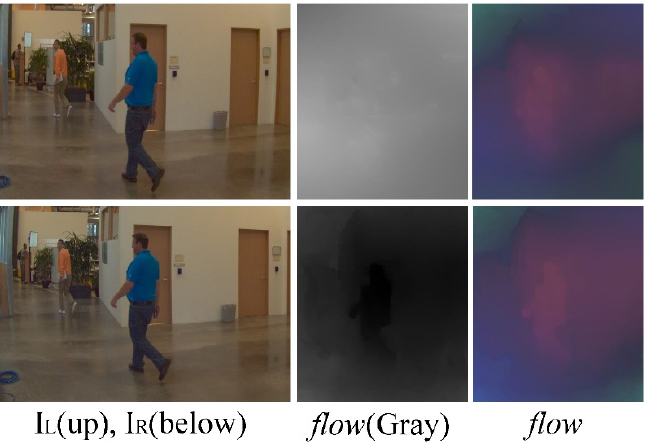
Figure 3. Rectangular search can better detect the foreground and keep its outline. The upper are the optical flows obtained by a 5 × 5 patch, and the lower are the results of the extended rectangular search box. A color wheel is used to color the gray version of the flow to give an obvious effect.